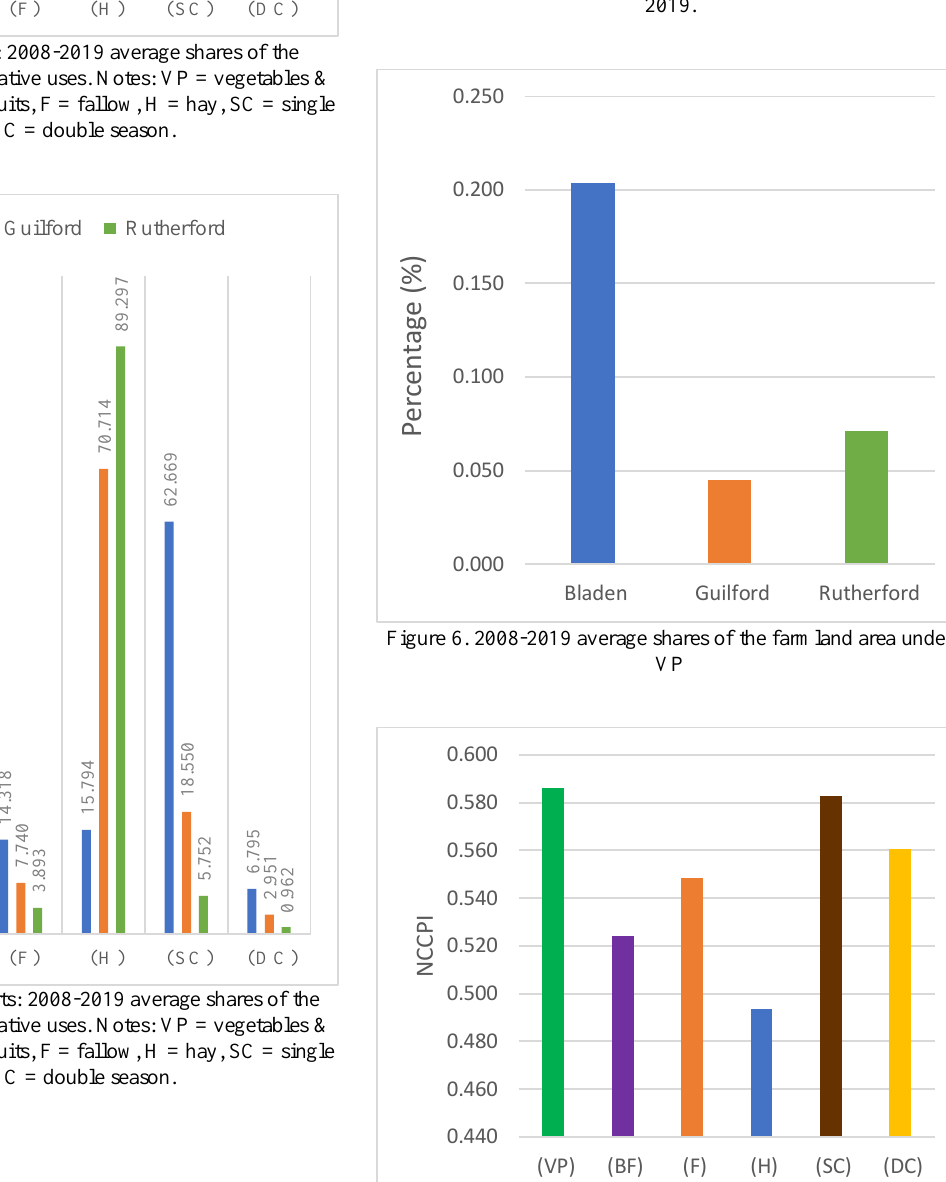
Figure 7. 2008-2019 average productivity of the farmland area under alternative uses. Notes: VP = vegetables & produce, BF = berries & fruits, F = fallow, H = hay, SC = single season, DC = double